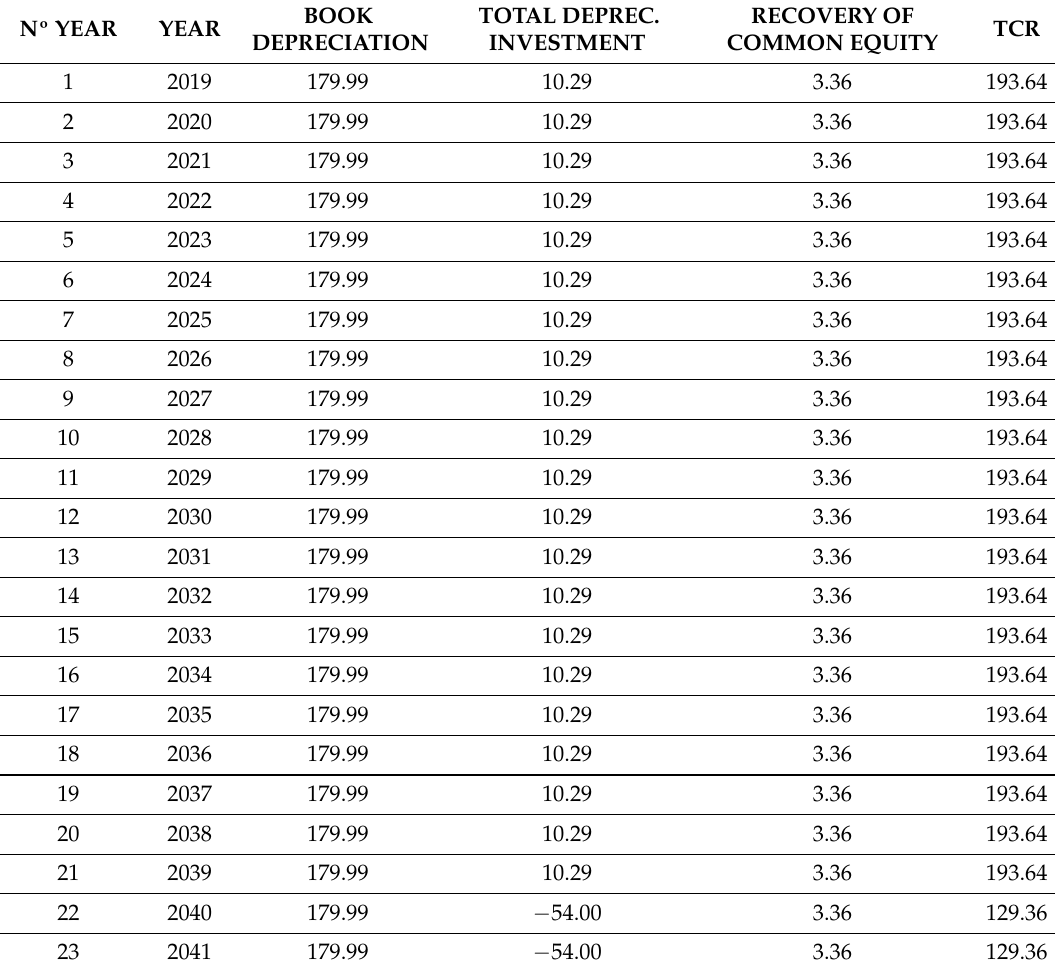
Table A3. Total capital recovery (TCR) (in millions of